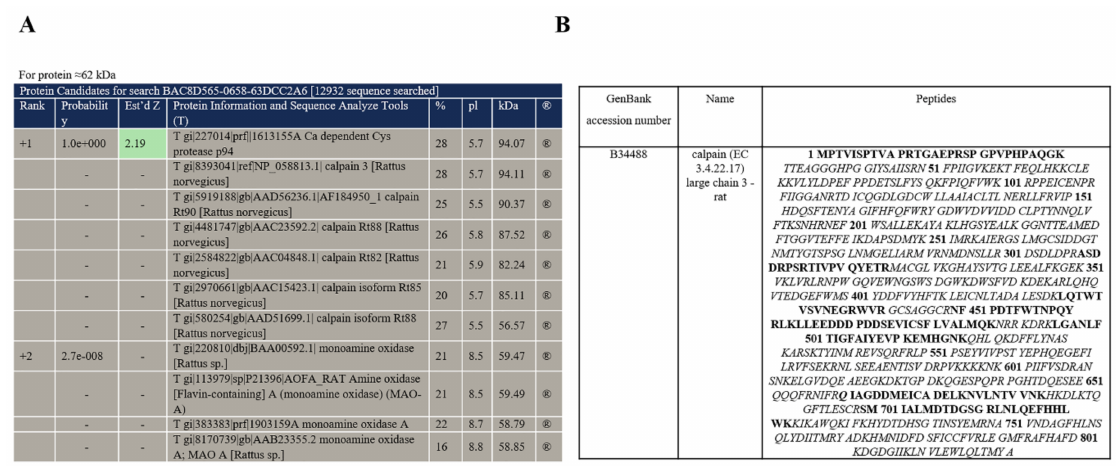
Figure 1. Scheme of detection and purification of 60–62 kDa phosphoprotein in RBM loaded with threshold Ca 2+ . ( A ): Au- toradiogram of phosphorylated proteins obtained after separation of intact (control) and Ca 2+ -loaded (mPTP) mitochondria on 15% SDS-PAGE (10 µ g protein per line) The molecular mass of the phosphoproteins is indicated. ( B ): Scheme and results of 2D electrophoresis. Proteins from the mitochondrial suspension were subjected to separation in the first dimension by isoelectric focusing (ISF) (( B ), upper part). The 62 kDa phosphoprotein was cut off and re-run on 15% SDS-PAGE (the 2nd dimension) On the left part—scan of the gel after staining with silver nitrate. On the right part—autoradiogram after gel exposure. The protein spots indicated by the circles were excised from the gel for mass spectrometry.